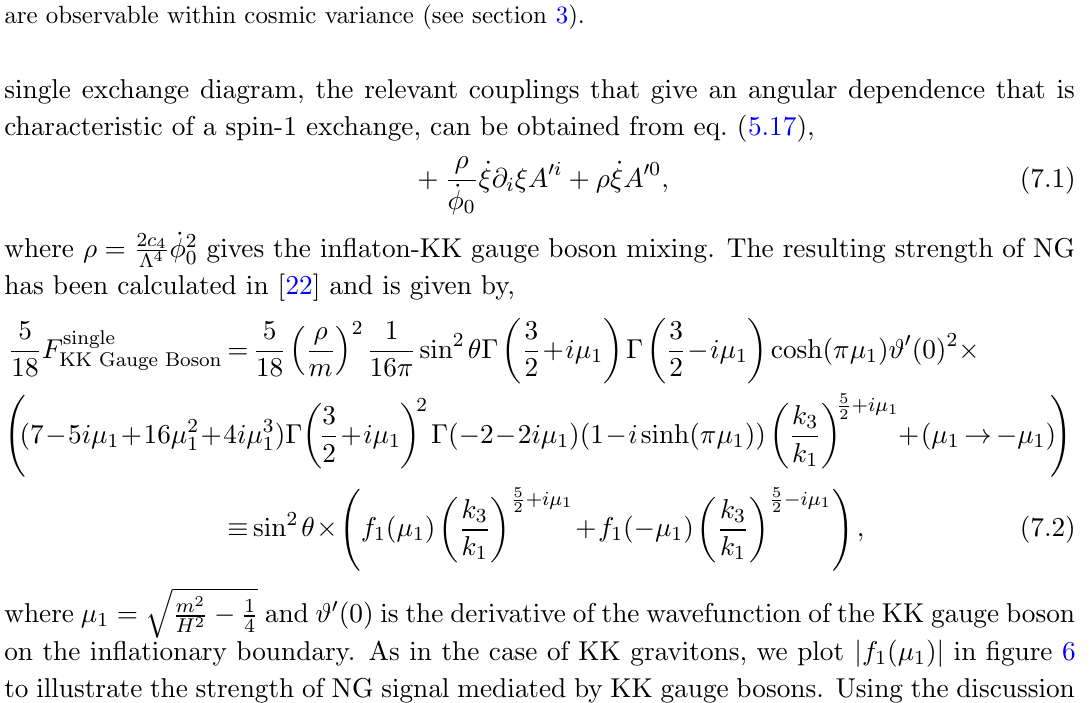
Figure 5 . Strength of NG mediated by spin-2 KK graviton for tensor-to-scalar ratio r = 0 : 1 and KK wavefunction on in(cid:13)ationary boundary (0) = 1. Such strengths for the range of masses shown are observable within cosmic variance (see section